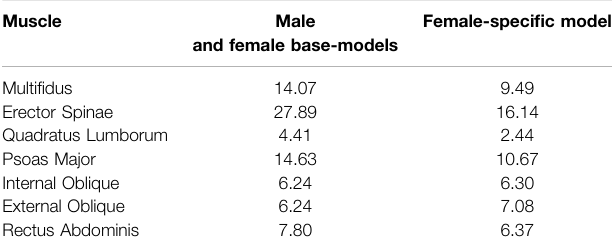
TABLE2| PCSAs(cm 2 )oftrunkmusclesformaleandfemalebase-modelsaswell as female-speci fi c model.